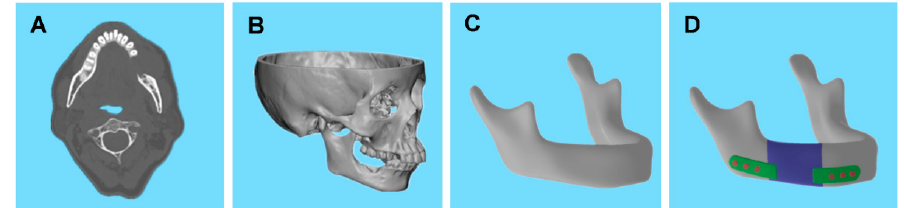
Figure 2. Mandible preparation and implant design. ( A ) CT image of defective mandible. ( B ) Three- dimensional model of maxilla and mandible. ( C ) Repaired mandible. ( D ) Reconstructed mandibular model, including residual mandible (gray), design model (blue), plates (green), and screws (orange). An optimal unit cell was used to construct the prosthesis and repair the mandibular physiological loading conditions. Two static clenching tasks were simulated: incisal clenching (INC) and left unilateral molar clenching (LMOL) by applying muscle forces to